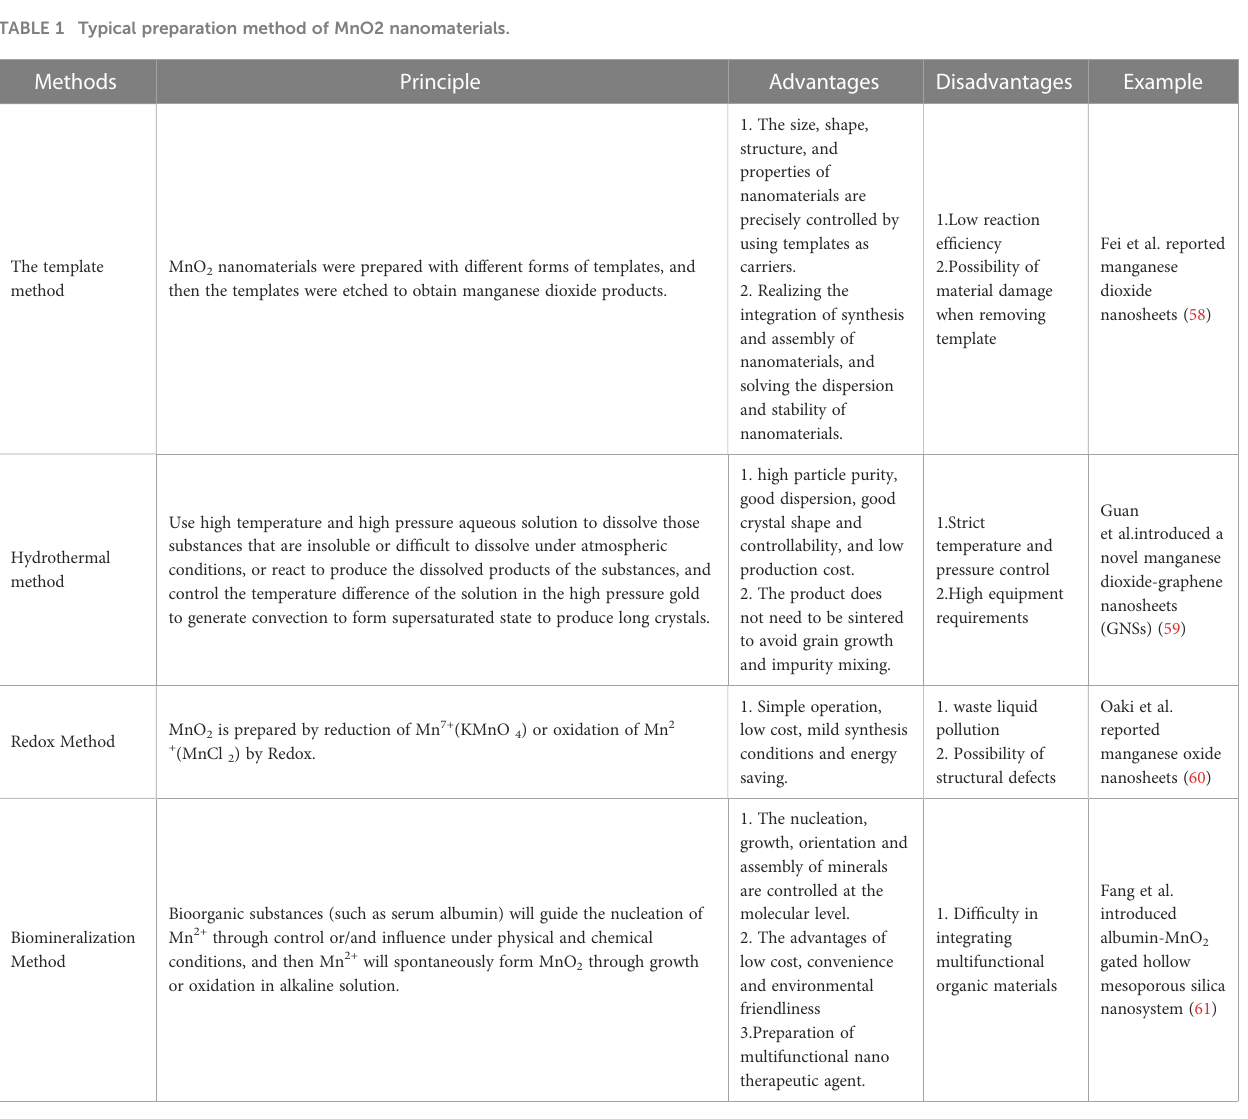
TABLE 1 Typical preparation method of MnO2